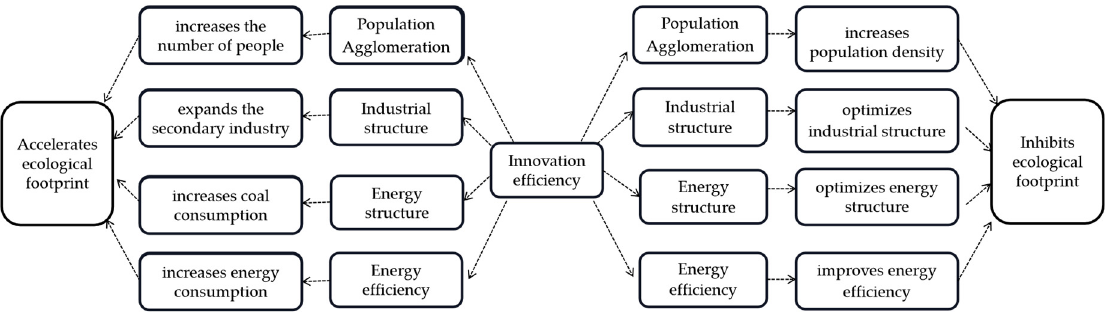
Figure 1. Mechanisms of the impacts of innovation efficiency on the ecological footprint.